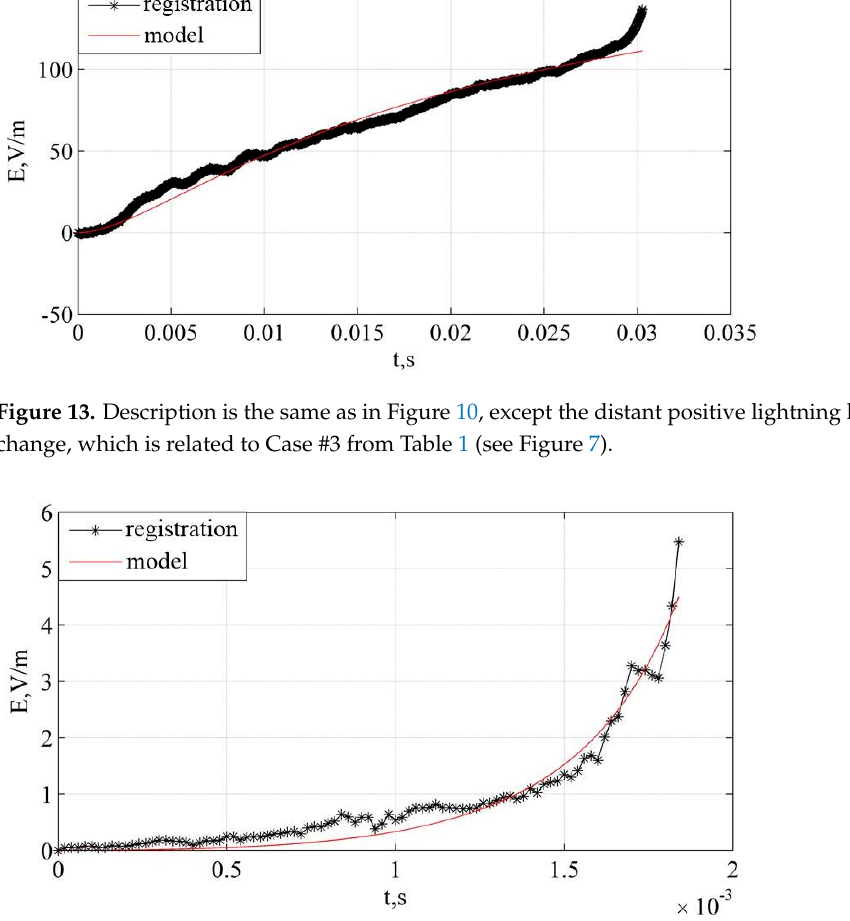
Figure 14. Description is the same as in Figure 10, except the distant positive lightning leader E-field change, which is related to Case #11 from Table 1 (see Figure 8).